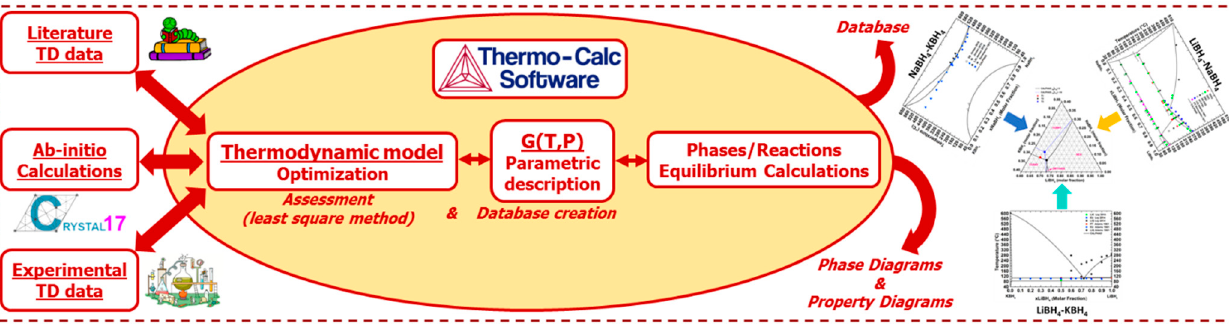
Figure 3. Flowchart of the assessment procedure using the CALPHAD method.